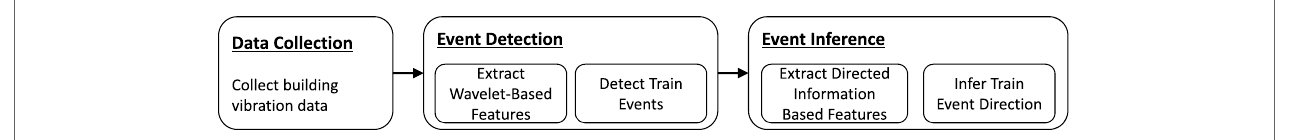
FIGURE 2 | Framework of the algorithm